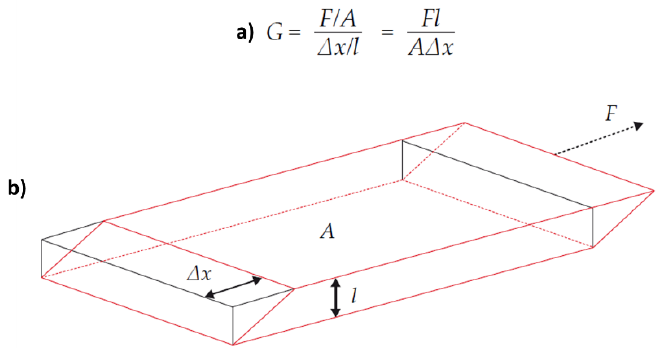
Figure 1 . Shear elastic modulus. ( a ) Mathematical formula to express shear modulus; ( b ) Schematic representation of the shear principle. G = shear modulus; F = force; A = area; F/A = shear stress; Δ 𝑥 = transverse displacement; l = initial length. Reproduced with permission from [4].